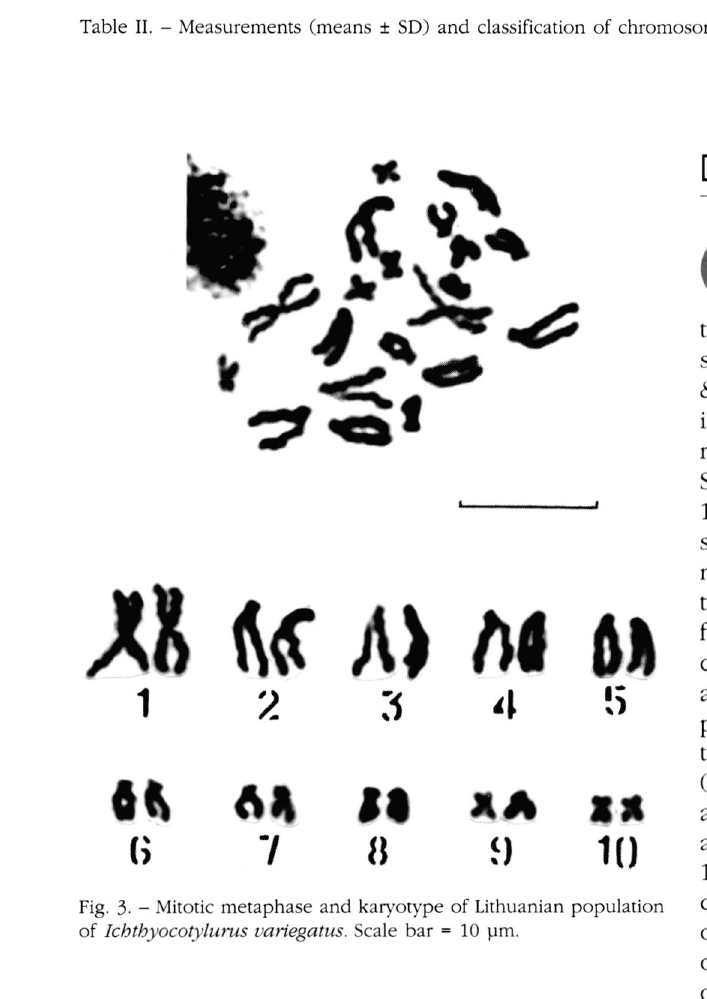
Fig. 3- - Mitotic metaphase and karyotype of Lithuanian population of Ichthyocotylurus variegatus. Scale bar = 10 um.